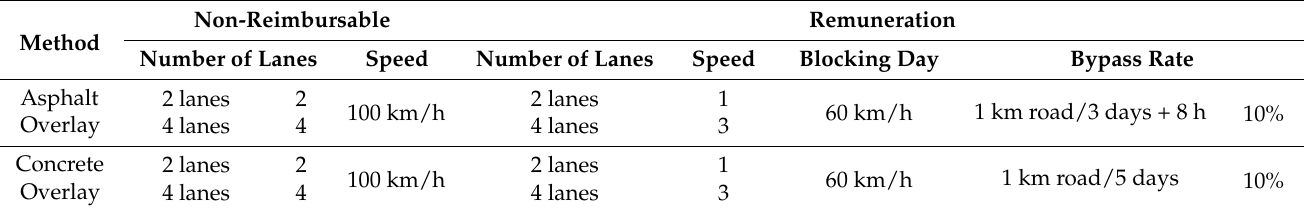
Table 1. Variables applied to user cost (complete blocking).